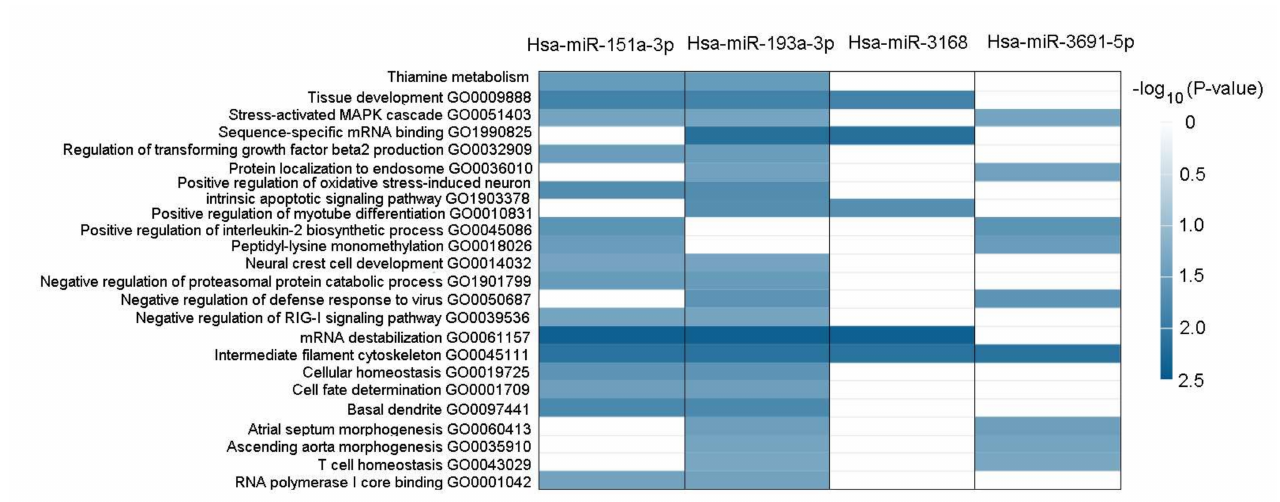
Figure 9. Pathways and gene ontology of the BDNF-regulated miRNAs analyzed by the miRNA enrichment analysis and annotation